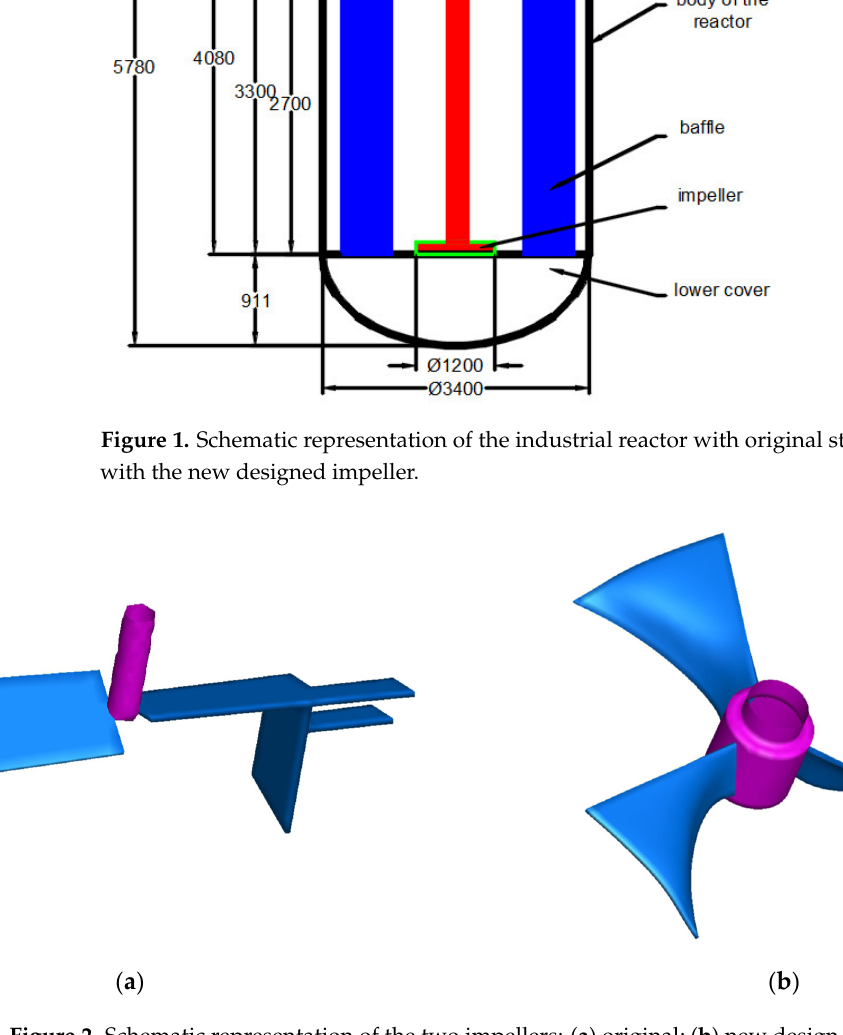
Figure 2. Schematic representation of the two impellers: ( a ) original; ( b ) new design.